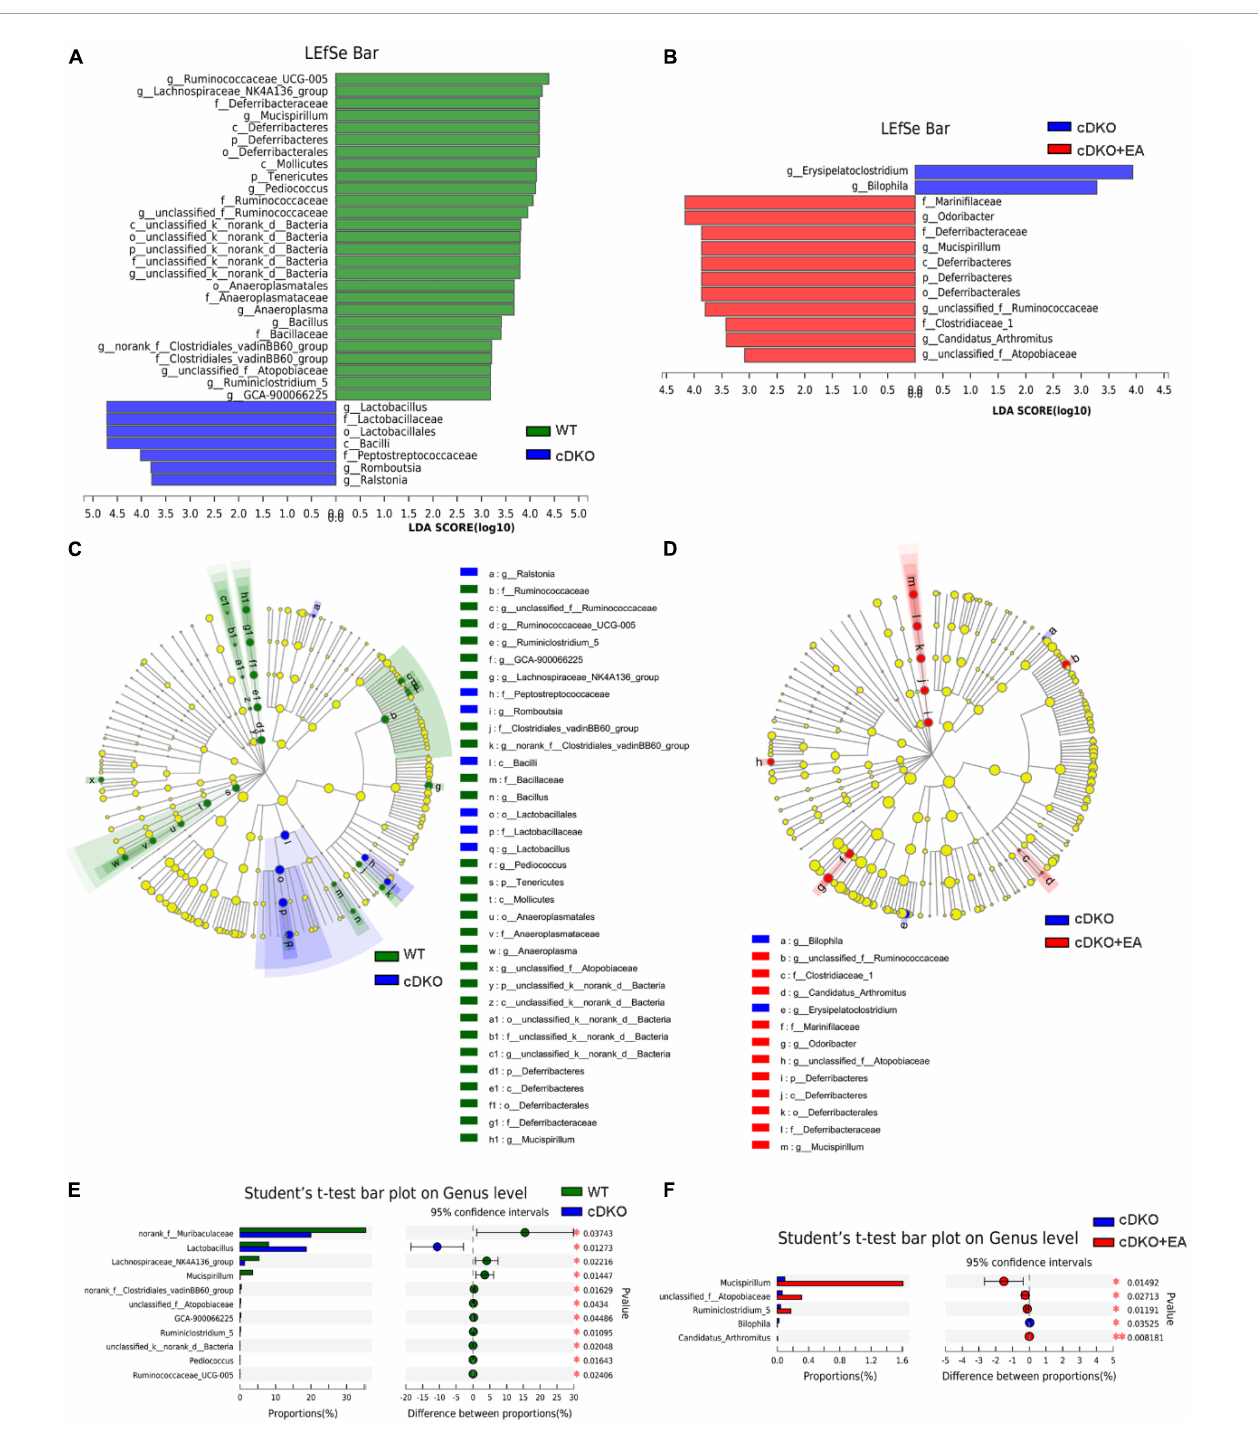
FIGURE6 The taxa of gut microbiota affected by electroacupuncture. LEfSe analysis from the phylum to genus level in the WT and cDKO groups (A) , the cDKO and cDKO + EA groups (B) . Taxa enriched in three groups are indicated by LDA scores (green for the WT group, blue for the cDKO group, and red for the cDKO + EA group). The LDA score threshold is ≥ 3. (C,D) The cladogram of enriched taxa from the phylum to genus level. Differential abundance analysis of taxa on the genus level in the WT group and the cDKO group (E) , the cDKO group, and the cDKO + EA group (F) . Student’s t -test, ∗ P < 0.05, ∗∗ P < 0.01, N =